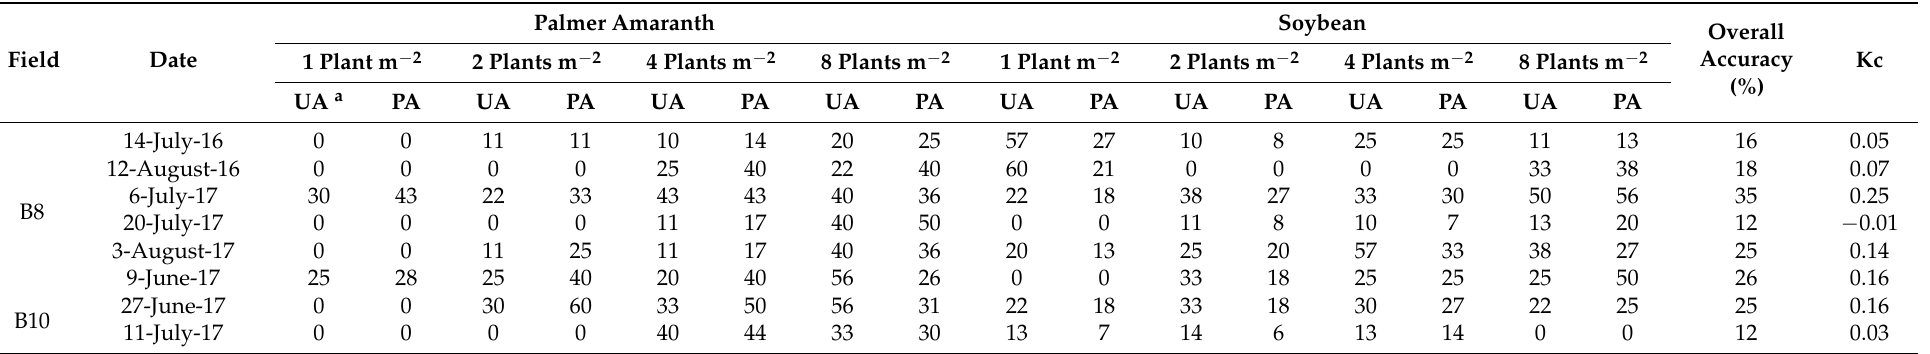
Table 9. Summary of the eight-class supervised classification accuracies for Palmer amaranth and soybean detection growing in mixed stands from aerial imagery collected from an altitude of 15 m at two separate fields at Rocky Mount, NC in 2016 and